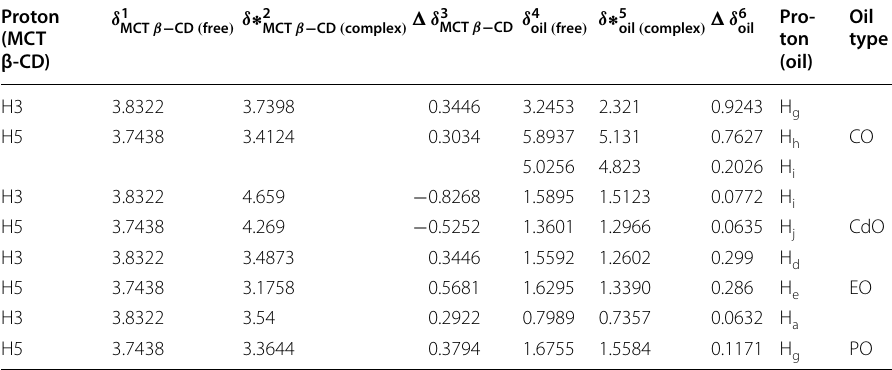
δ 1 MCT β − CD ( free ) , chemical shift of MCT β‑CD in free state; δ ∗ 2 MCT β − CD ( complex ) , chemical shift of MCT β‑CD in complex with oils; �δ 3 MCT β − CD , induced shift of MCT β‑CD ( δ 1 MCT β − CD ( free ) − δ ∗ 2 Complex ); δ 4 oil ( free ) , chemical shift of oils in free state; δ ∗ 5 oil ( complex ) , chemical shift of oils in complex with MCT β‑CD; �δ 6 oil , induced shift of oils ( δ 4 oilfree − δ ∗ 5 oil )